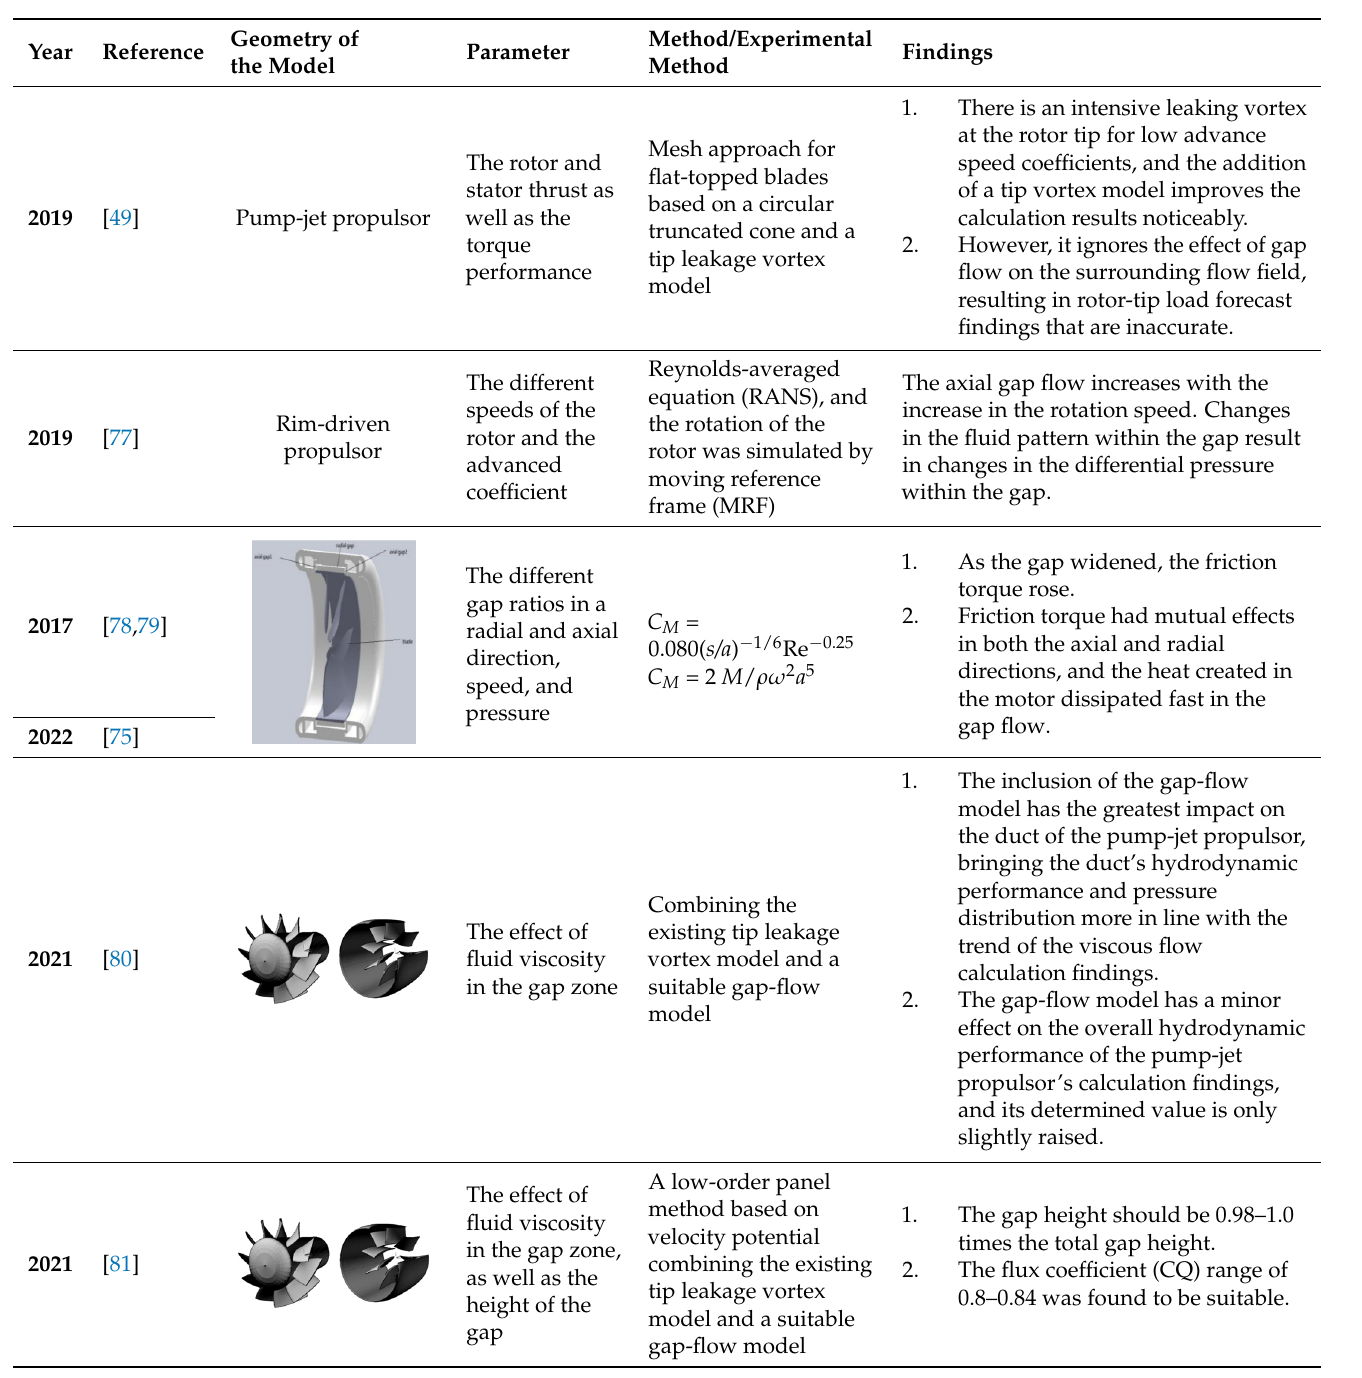
Figure 8. Interaction between duct and hull of a yacht: ( a ) yacht equipped with two RDTs; ( b ) water flow pattern behind the RDT [39].